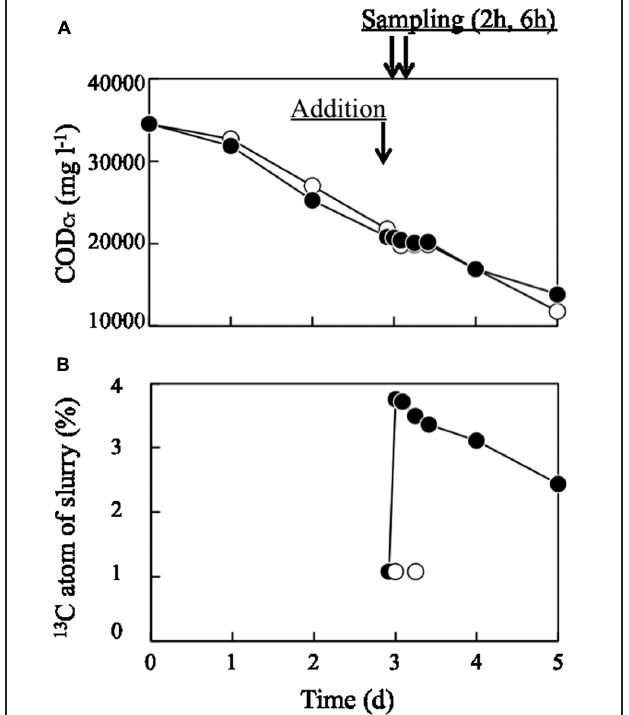
FIGURE 1 | Changes in (A) COD Cr and (B) 13 C atom% in aerated pig manure slurry. Closed and open circles represent treatments with 13 C-labeled and unlabeled (control) dead Escherichia coli cells, respectively. Arrows represent the time at which dead E. coli cells were added and sampling times (2 and 6 h